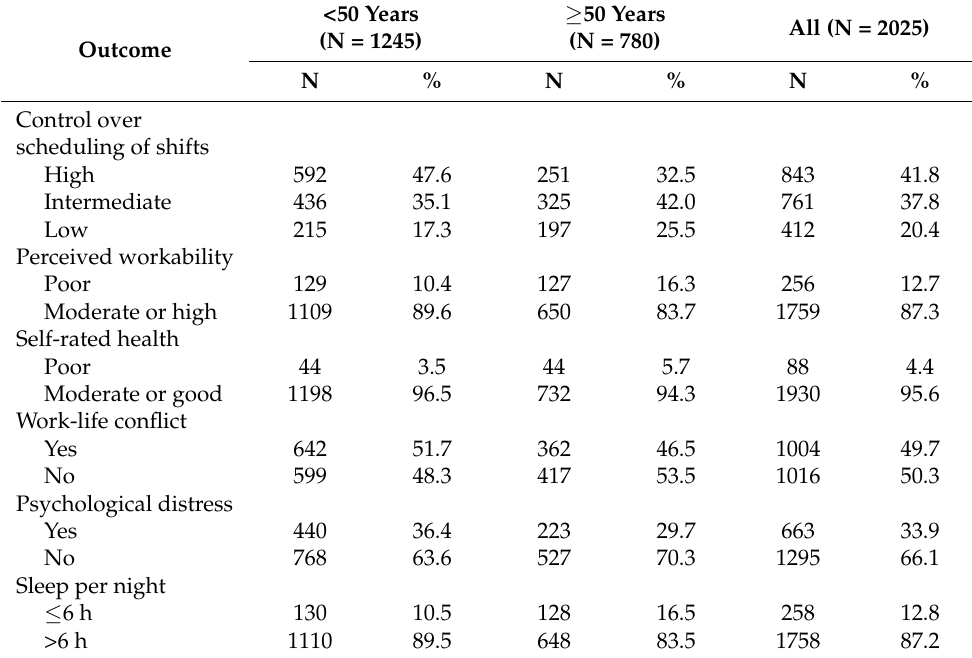
Table 2. The prevalence of the study outcomes at follow-up by age